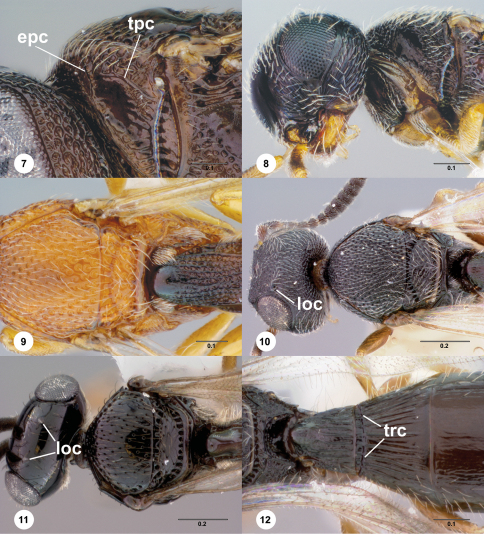
63 7Probaryconussp., pronotum, lateral view, female (OSUC 146809)8 Probaryconussp., head and pronotum, female (OSUC 58741)9 Probaryconussp., mesosoma and T1, dorsal view, female (OSUC 404933)10 Probaryconus rufipes (Kieffer), head and mesosoma, dorsal view, female (OSUC 396820)11 Paridrissp., head, mesosoma, T1, dorsal view, female (OSUC 262120)12 Paridrissp., metascutellum, propodeum, T1–T2, dorsal view, female (OSUC 265183). Scale bar in millimeters.